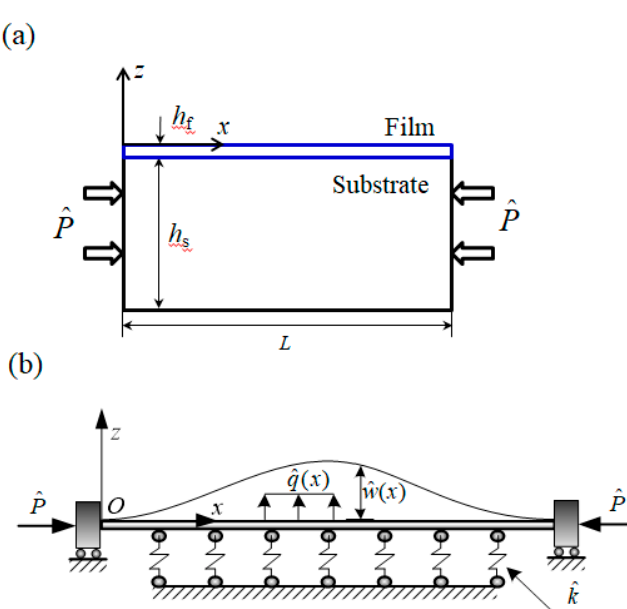
Figure 1. ( a ) Schematic of thin film on a compliant substrate and ( b ) the deformation of the analytical model in the first-order bucking mode with an elastic foundation.